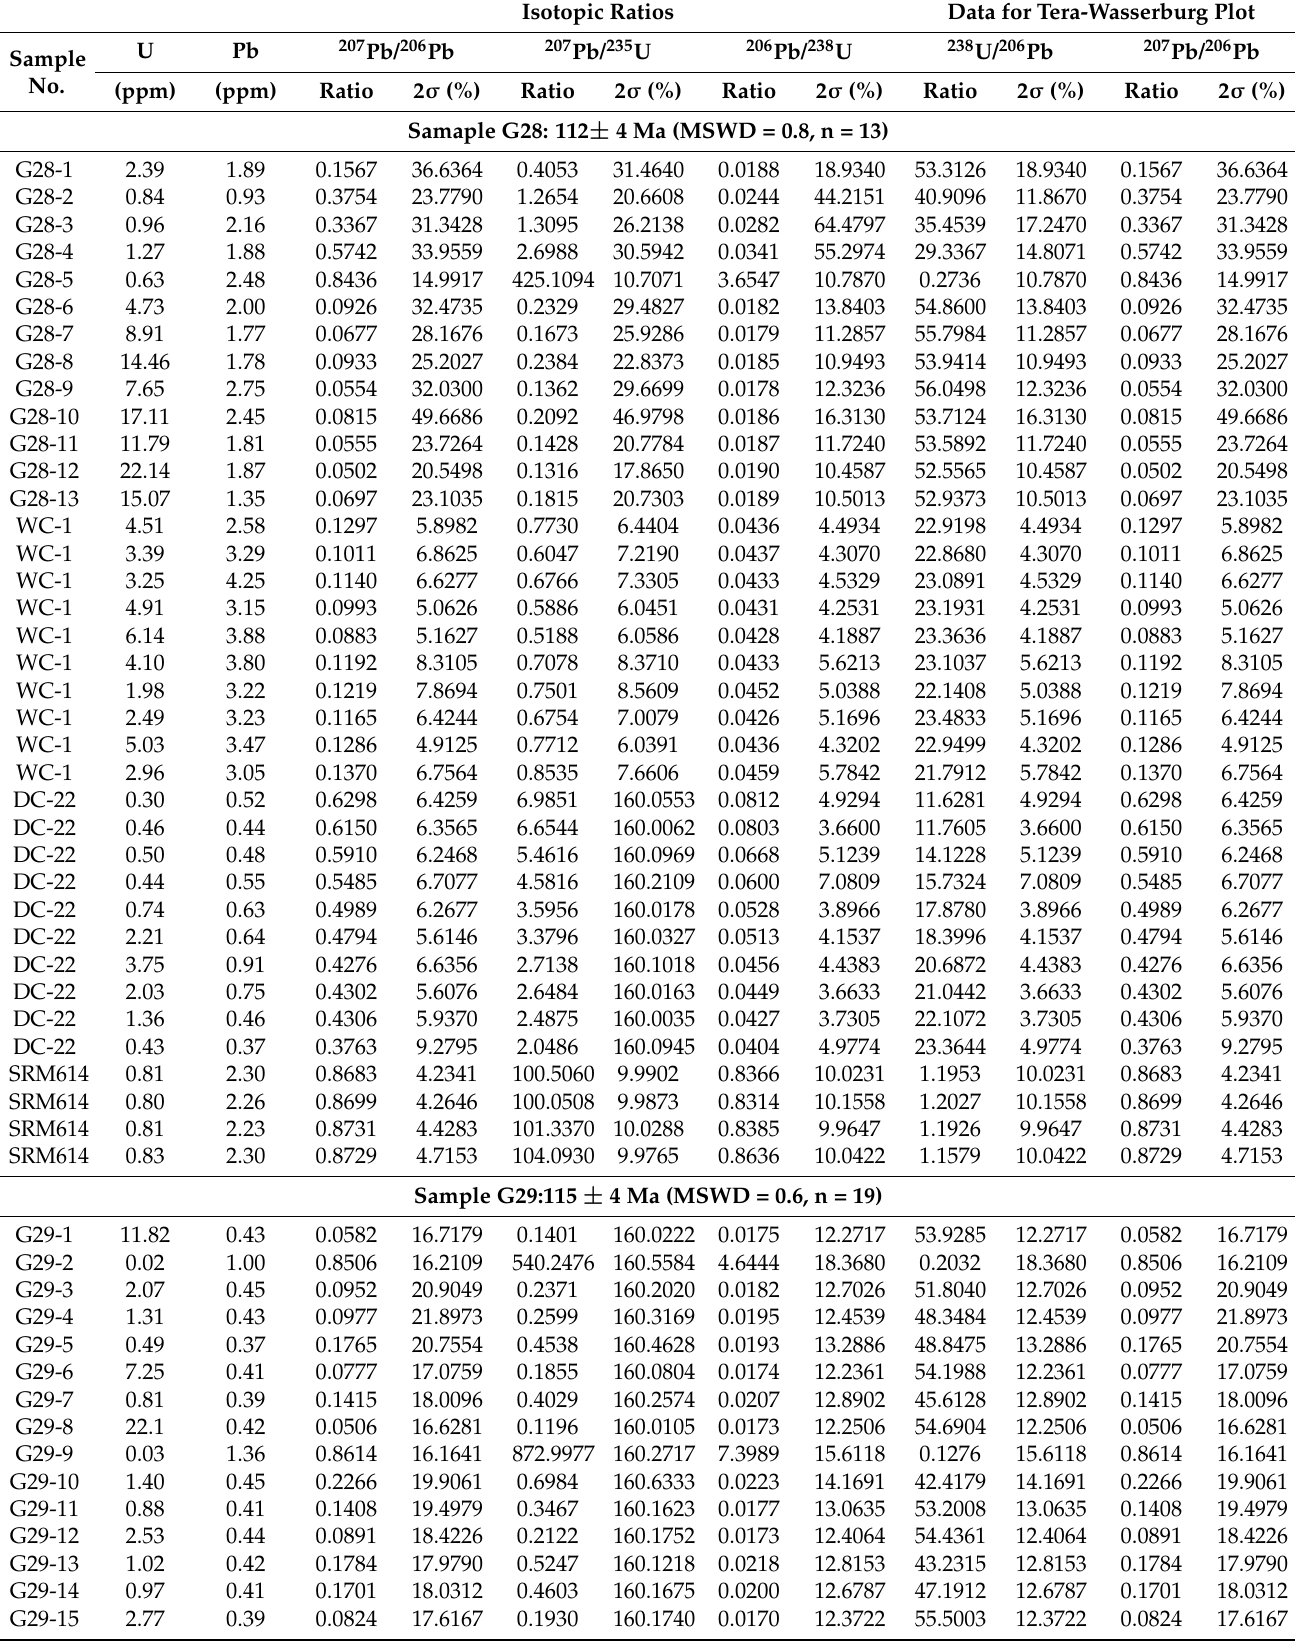
Table 1. LA-ICP-MS dolomite U-Pb dating results of sample G28 and